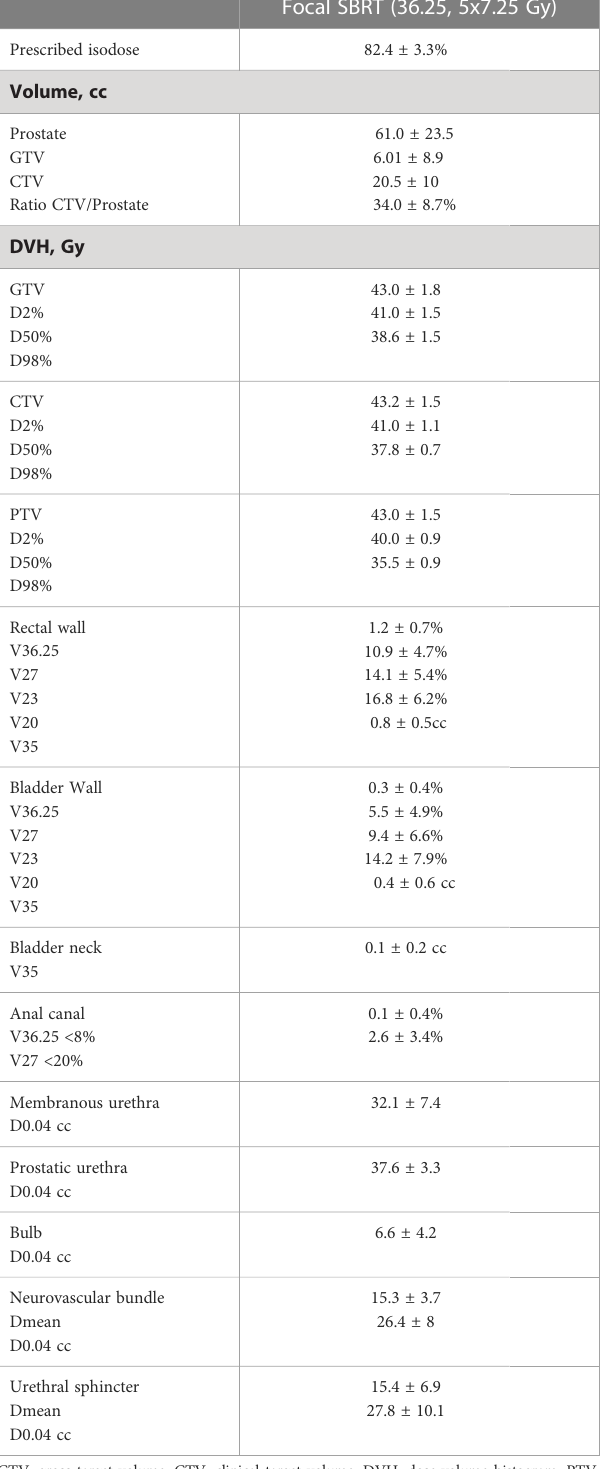
TABLE 2 Dose volume histogram variables of the